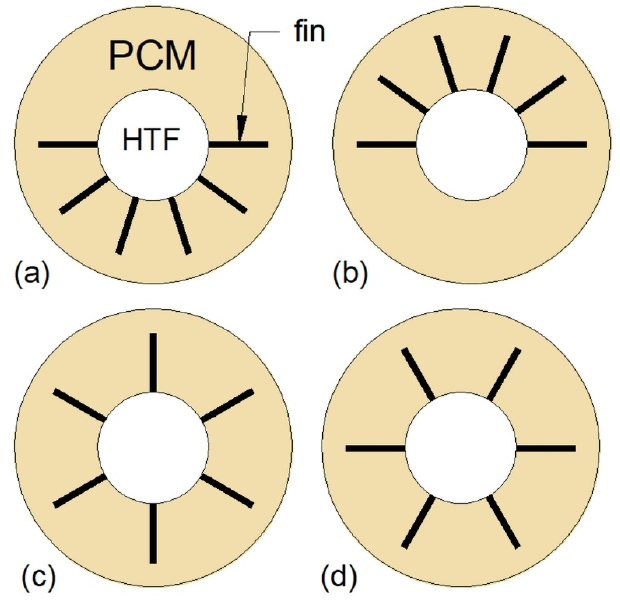
Figure 10. DTHX with: ( a ) Bottom fins, ( b ) upper fins, ( c ) straight fins, ( d ) angled fins [91].